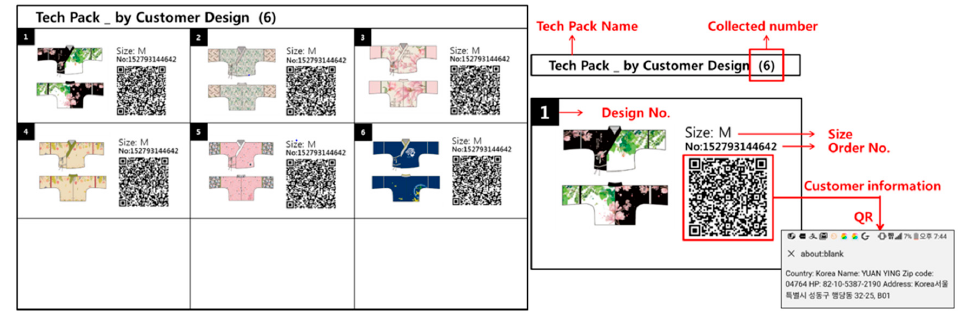
Figure 23. Additional tech pack for one person one item mass production.